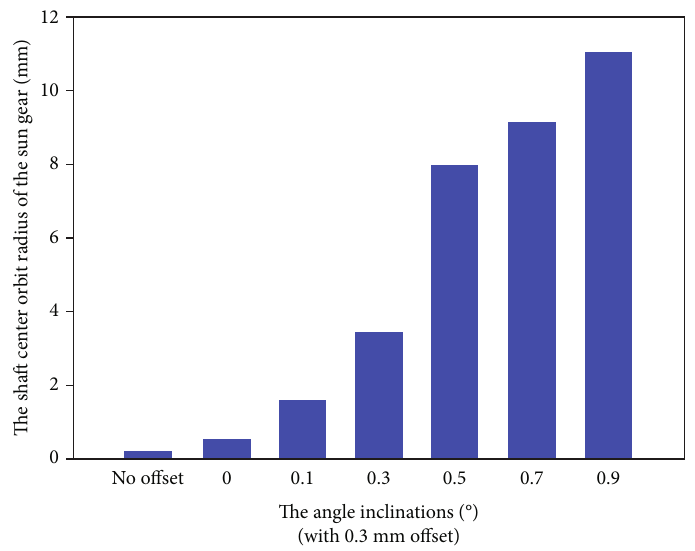
Figure 11: The variations in the shaft center orbit radius of the sun gear with di ff erent inclination